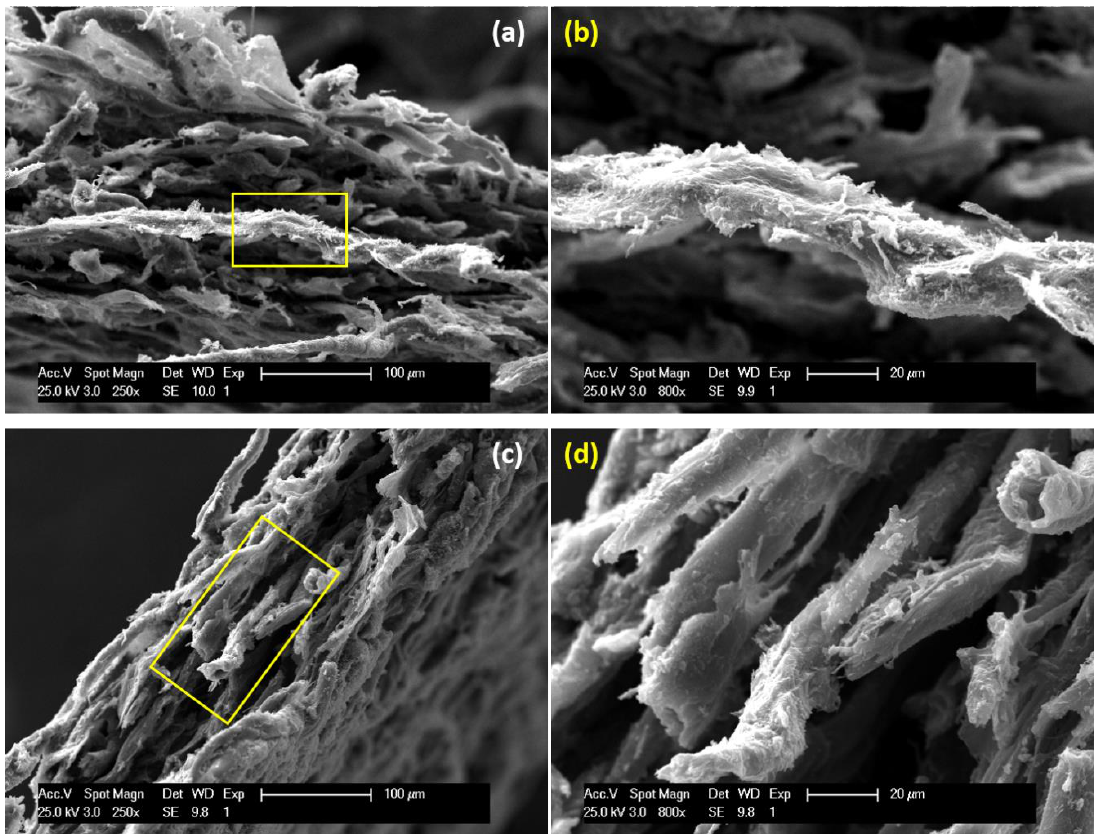
Figure 3. Cross-sectional SEM micrographs of ( a , b ) PTfCSp; and ( c , d ) PTfWSp. Micrographs ( a ) and ( c ) correspond at 250 × magnification and micrographs ( b , d ) to the enlargement of the yellow boxed area (800 × magnification).